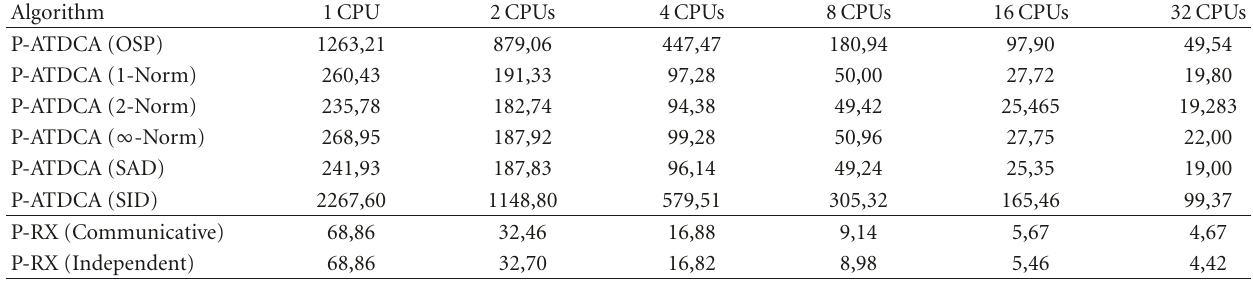
Table 5: Processing times in seconds measured for P-ATDCA (implemented using di ff erent distance measures) and P-RX, using di ff erent numbers of CPUs on the Thunderhead Beowulf